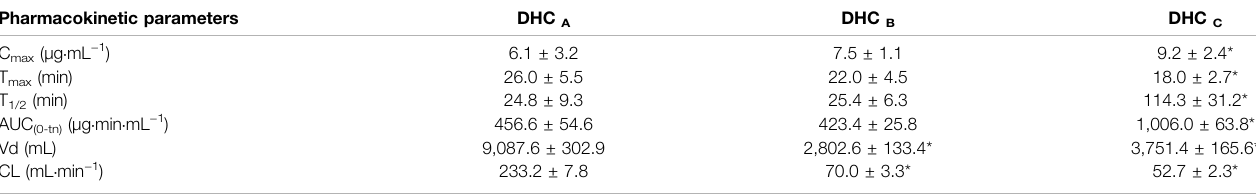
TABLE 5 | Pharmacokinetic parameters of DHC.